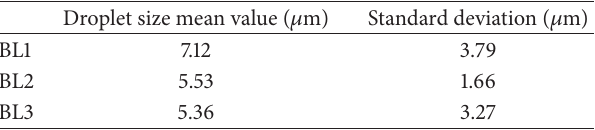
Table 6: Measured droplet size.